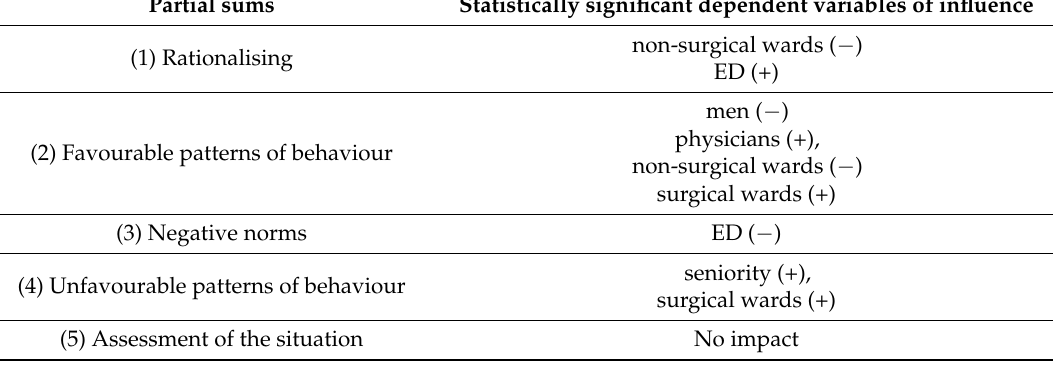
Table 4. Diversification of the impact of selected measurable descriptors on partial indexes of support towards SPs (reference levels: sex—female; occupation—nurses; place of work—ICUs. The (+/–) symbol indicates the direction of influence from the analysis of covariance.